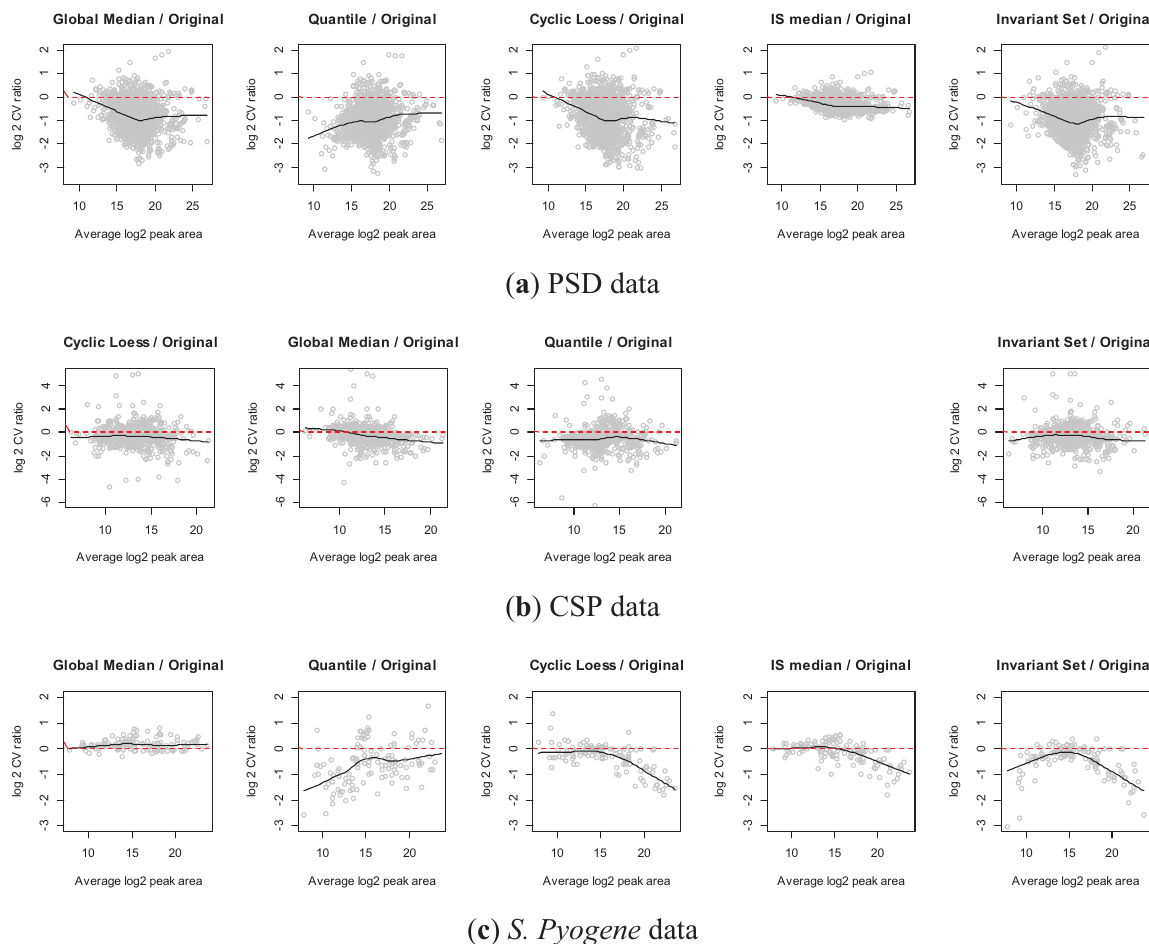
Figure 8. Comparisons of each normalization method vs. original data (( a ) PSD, ( b ) CSP, and ( c ) S. Pyogene ). Each plot shows the log2 ratio of CVs on y-axis and the average peak area on x-axis. Black line is a smoothing curve illustrating the overall pattern and the red dashed line indicates equal CV between normalized and original